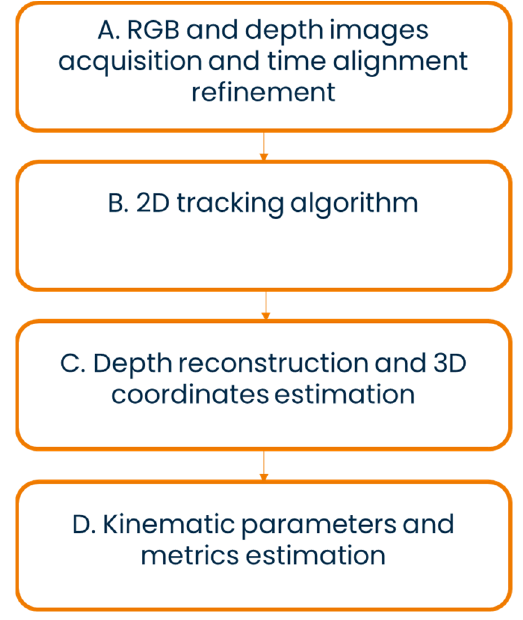
Figure 1. Block diagram of the proposed markerless-based method.